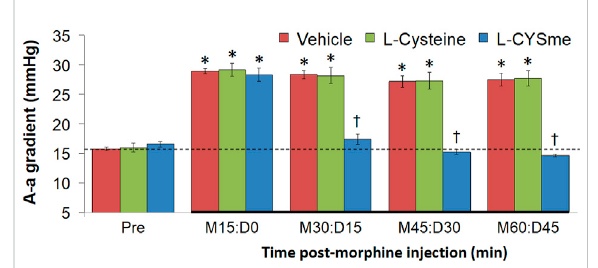
FIGURE 11 Alveolar-arterial (A-a) gradient values before (Pre) and after injection of morphine (10 mg/kg, IV) in three groups of freely- moving rats followed by injection of vehicle (VEH, saline), L-Cysteine (500 μ mol/kg, IV) or L-cysteine methyl ester (L-CYSme, 500 μ mol/kg, IV). The terms M15, M30, M45 and M60 denote 15, 30, 45 and 60 min after injection of morphine. The terms D0, D15, D30 and D45 denote 0, 15, 30 and 45 min afterinjectionofdrug(vehicle,L-CysteineorL-CYSme).Thedata are mean ± SEM. There were 9 rats in each group. * p < 0.05, signi fi cant change from Pre values. † p < 0.05, signi fi cant change between L-CYSme versus